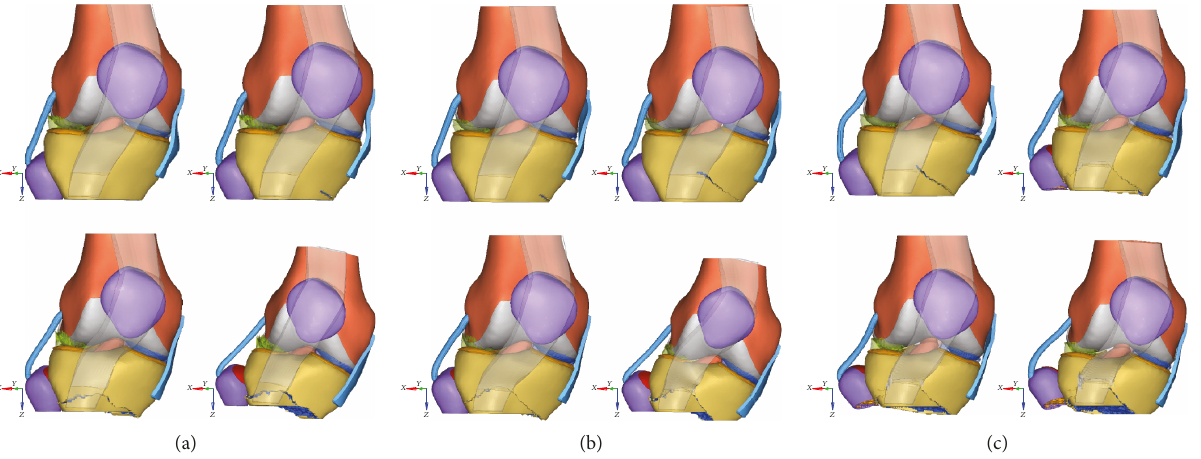
Figure 5: Knee kinematic process at the varied impact speeds ((a) 2.5 km/h; (b) 5.0km/h; (c)